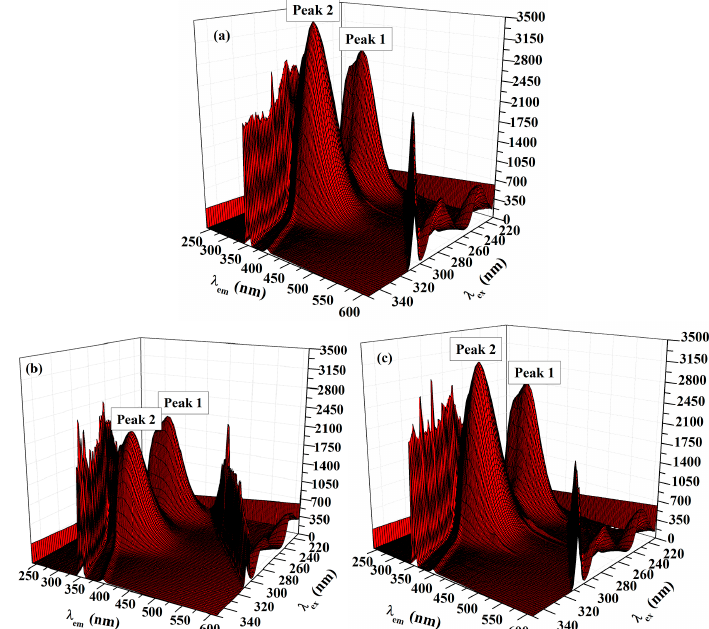
Figure 8. Three-dimensional (3D) spectra of HSA (1.5 μ M) in the ( a ) absence and ( b ) presence of ACV (35 μ M) and ( c ) in the presence of PNV (28 μ M).